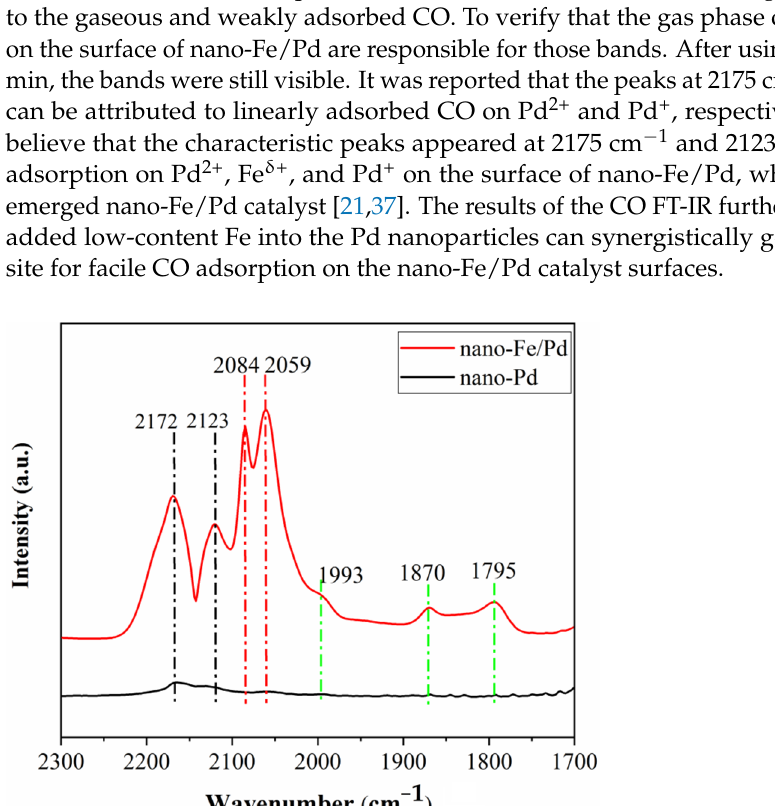
Figure 13. DFT optimized structures. ( a ) Pd (111) and ( b ) Fe/Pd (111), and CO or C 2 H 2 energetically favored adsorption configurations on catalyst surfaces. Table 3 shows the adsorption energies and bond lengths of C–O of CO and C ≡ C of C 2 H 2 of the adsorption state on the pure Pd (111) and Fe/ Pd (111) models, respectively. Remarkably, the CO adsorption energy E ads on the Pd (111) model surface ranged from − 139.4 kJ/mol to − 200.7 kJ/mol, which was roughly 150 kJ/mol less than CO adsorption on Fe/Pd (111) model surfaces at corresponding sites. It is suggested that the alloying of Fe atoms into the palladium lattice weakens the adsorption capacity of carbon monoxide of